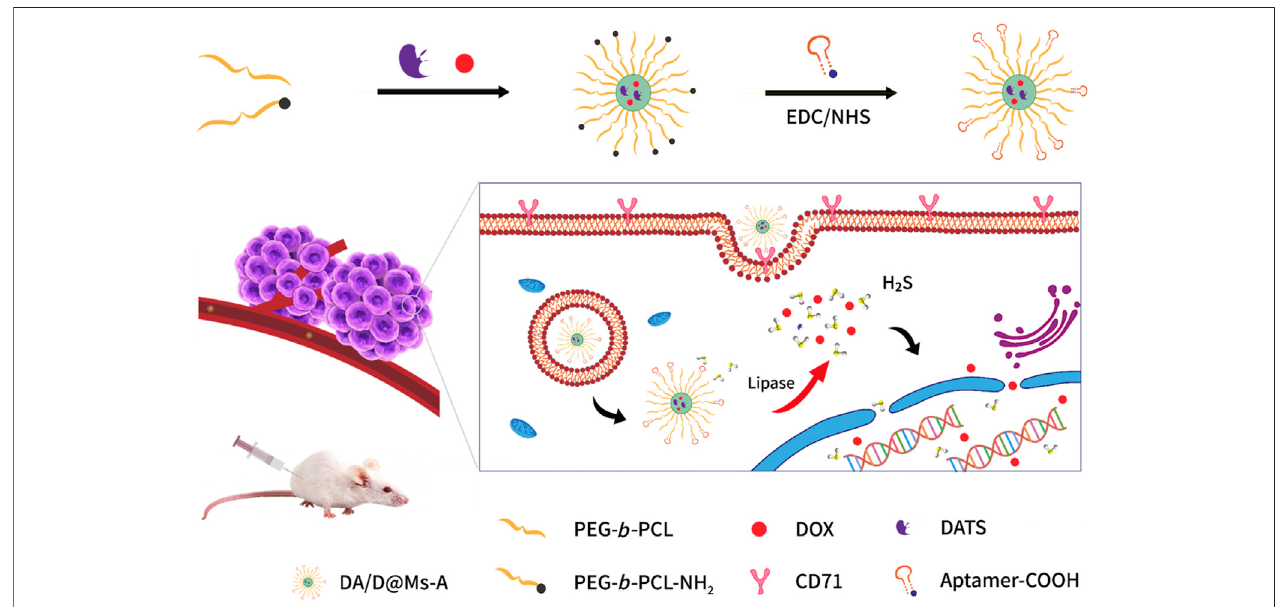
FIGURE 1 | Schematic illustration of the working mechanism of aptamer targeting micelles for synergetic chemo-H 2 S gas